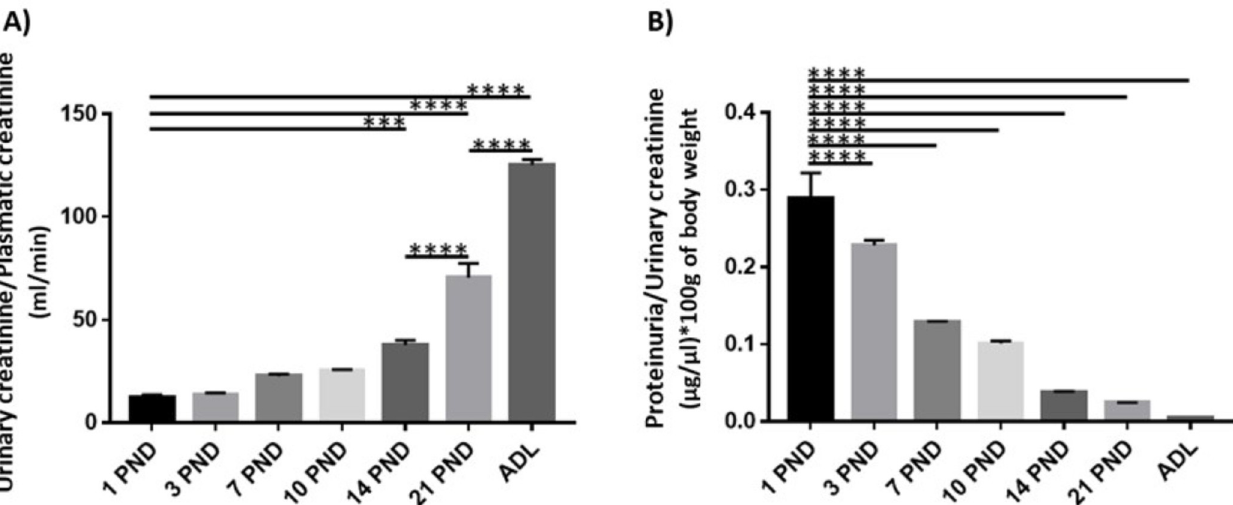
Fig 1. Physiological parameters of rats during postnatal development and in adulthood. A) analysis of the relation between urinary creatinine concentration and serum creatinine, finding a significant and progressive increase as the kidney matures. B) proteinuria analysis, we found the highest values in the first postnatal days (PND), decreasing significantly during renal maturation. Values are means ± standard deviation (SD). One-way ANOVA. * p < 0.05, **** p < 0.0001. A representative experiment is shown (n = 3).